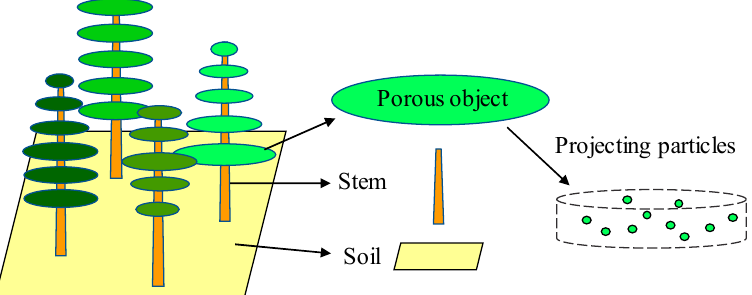
Figure 2. A sample forest scene in Radiosity Applicable to Porous IndiviDual objects (RAPID2); the forest scene consists of porous crowns, solid stems, and soil; the porous crowns are composed of many thin layers, which would be projected as particles dynamically in microwave domain at runtime.